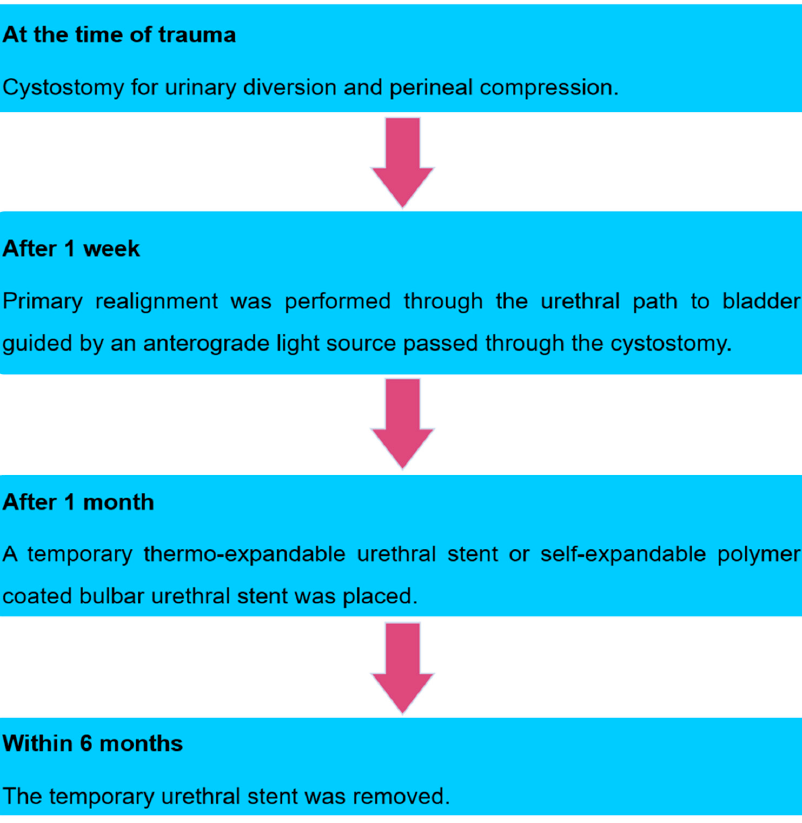
Figure 3. Treatment strategy algorithm.